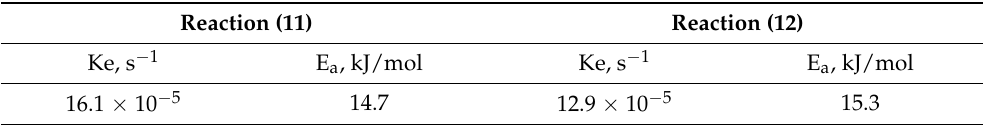
Table 3. The values of the rate constants and activation energies of the processes described by reactions (11) and (12).